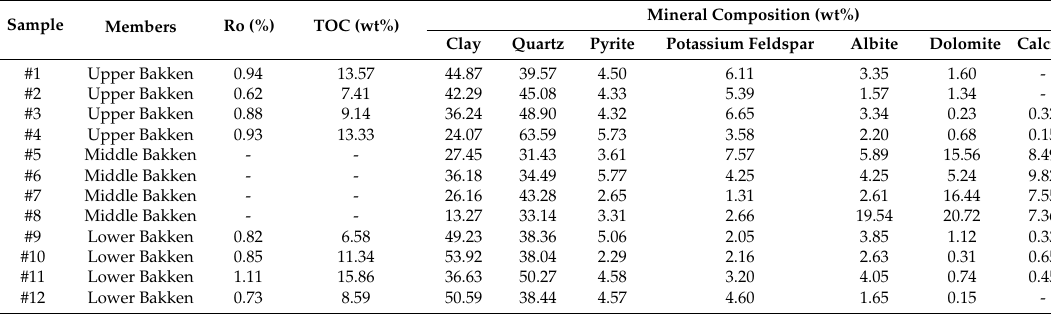
Table 1. The mineral composition and geochemical characteristics of the Bakken